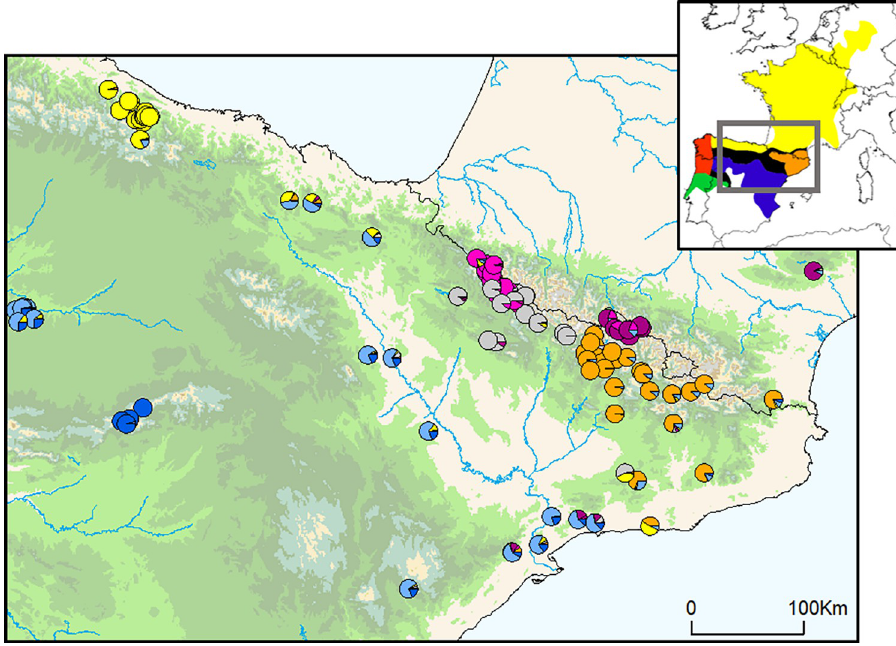
Fig 6. Results of Bayesian clustering analysis (STRUCTURE) for K = 7 microsatellite groups for Alytes obstetricans / almogavarii . Sampled populations are represented by pie charts highlighting the population cluster membership obtained in STRUCTURE. The inset map shows the distribution of the main lineages: orange—ND4 haplogroups E-F ( A . almogavarii ), yellow—ND4 haplogroup B ( A . o . obstetricans ), blue—ND4 haplogroup A ( A . o . pertinax ), red—ND4 haplogroup C ( A . o . boscai ), green—ND4 haplogroup D ( A . o . boscai ), black—unclear (adapted from Dufresnes and Martı´nez-Solano